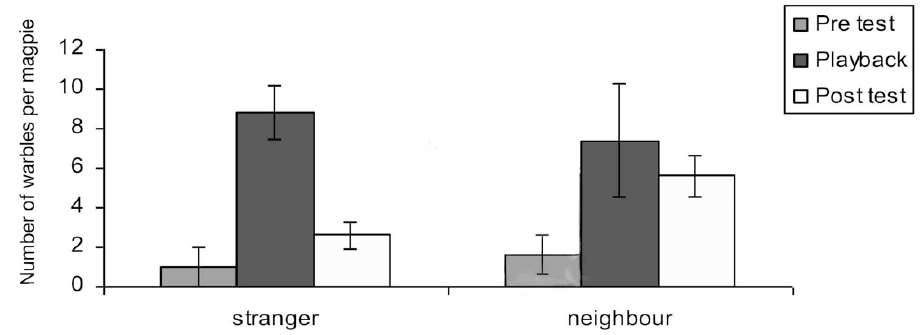
Figure 11. Warble responses by adults ( N = 10) to playback of warbles by neighbours or strangers. Graph indicates mean number and standard error of all adult warbles in response to warble playbacks. Note the importance of the post-playback period, showing that the alert vocal response continued after hearing a neighbour sing inside their territory, and there is a significant difference ( p = 0.002) between responses in the post-test period between hearing a stranger or a neighbour